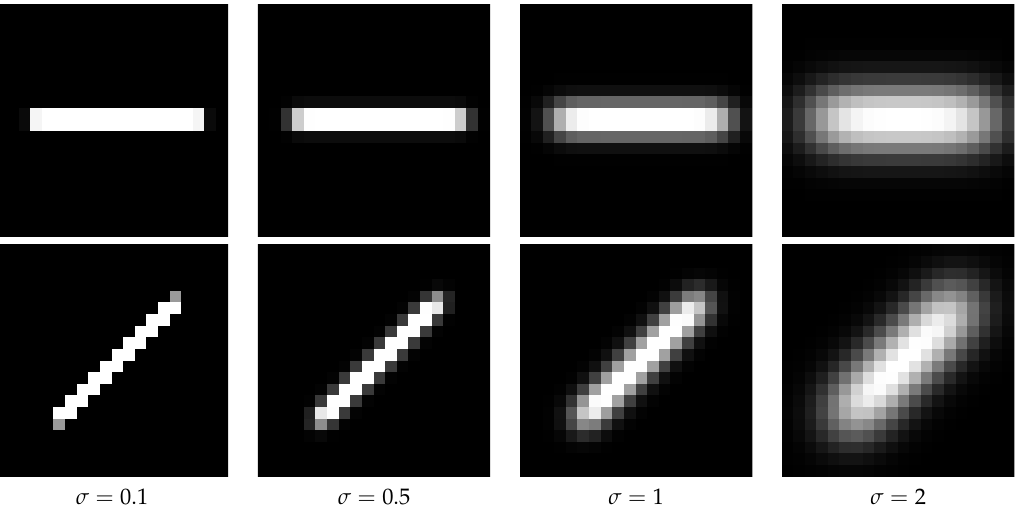
Figure 4. Different stripes of a particle resulting from different particle sizes and different angles of motion. The velocity of the illustrated particles is 15 pixel/exposure time. In the top row the angle is 0 ◦ and in the bottom row it is 45 ◦ . From left to right in the columns different particle sizes are presented. In all cases the x coordinate of the mean is centered in a pixel and the y coordinate of the mean is exactly centered between two